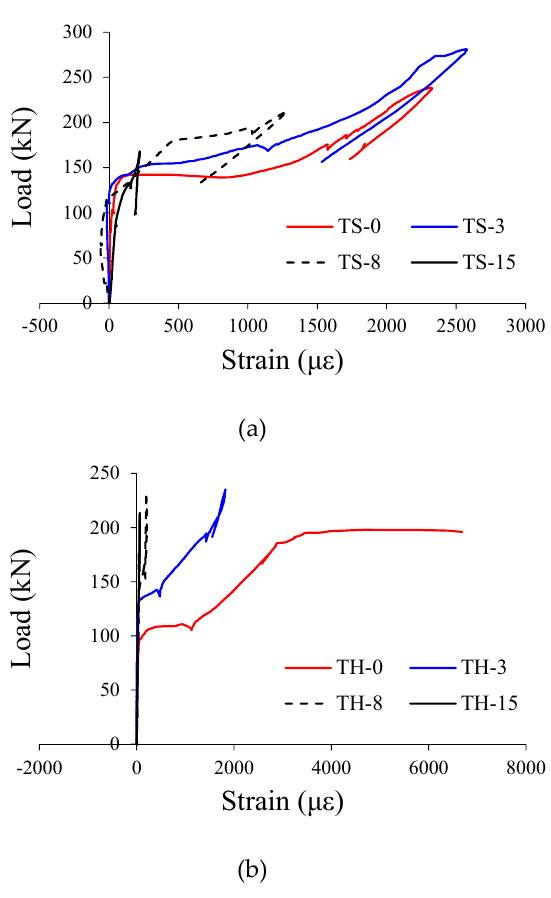
Figure 11. Measured strains of stirrups. ( a ) TS series specimens; ( b ) TH series specimens.